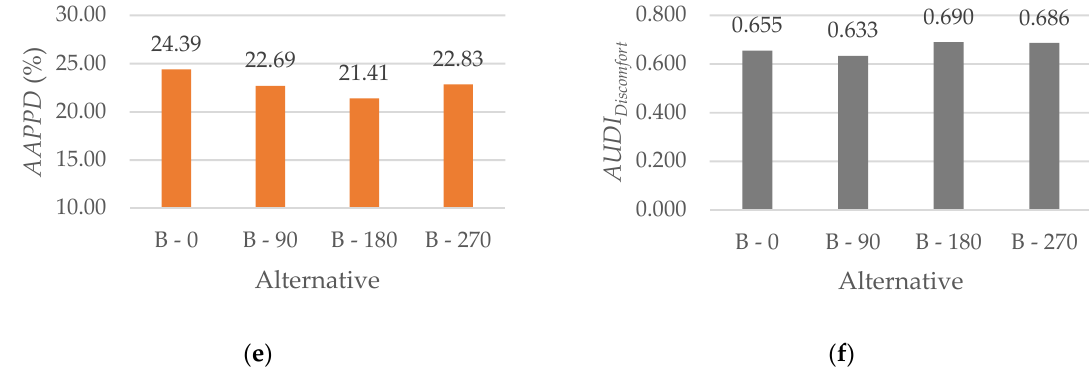
Figure 8. Annual profiles of the considered objective functions for different orientations of the building type B: ( a ) annual profiles of Q l ; ( b ) annual profiles of Q h ; ( c ) annual profiles of Q c ; ( d ) annual profiles of CO 2 -eq ; ( e ) annual profiles of AAPPD ; ( f ) annual profiles of AUDI Discomfort . Table 5. The TOPSIS results for different orientations of the building type B.